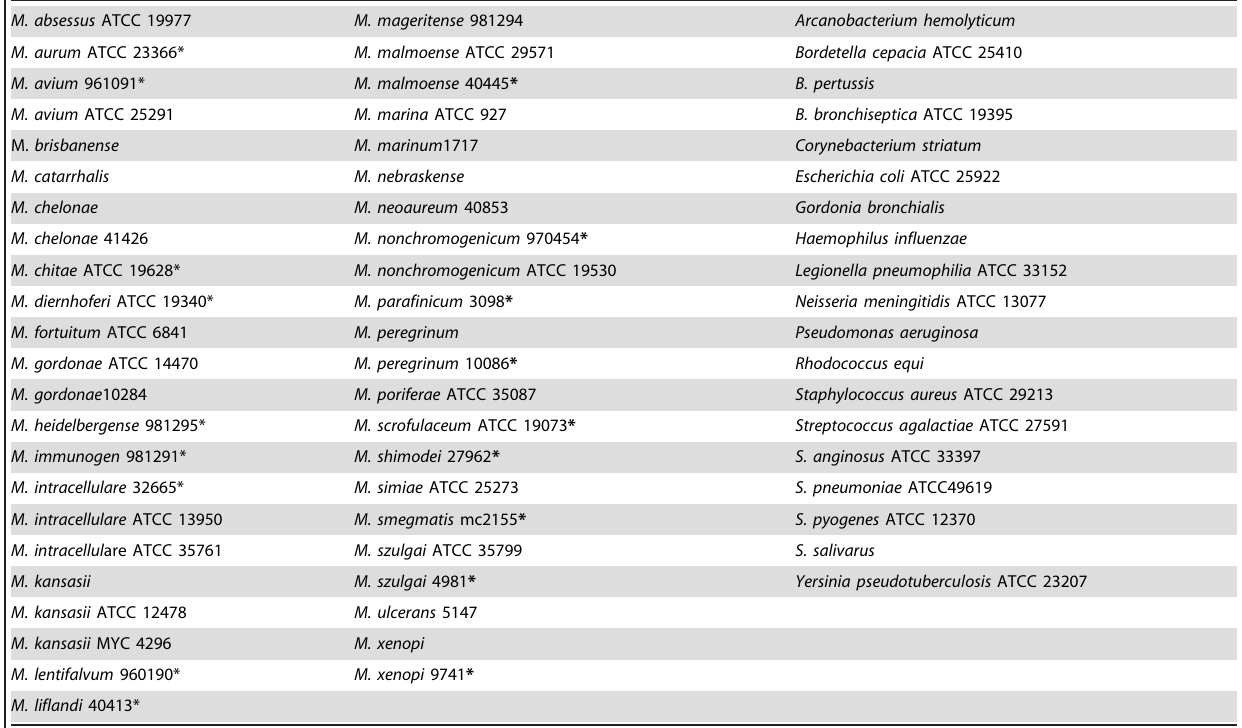
Table 1. Strains used for specificity testing.